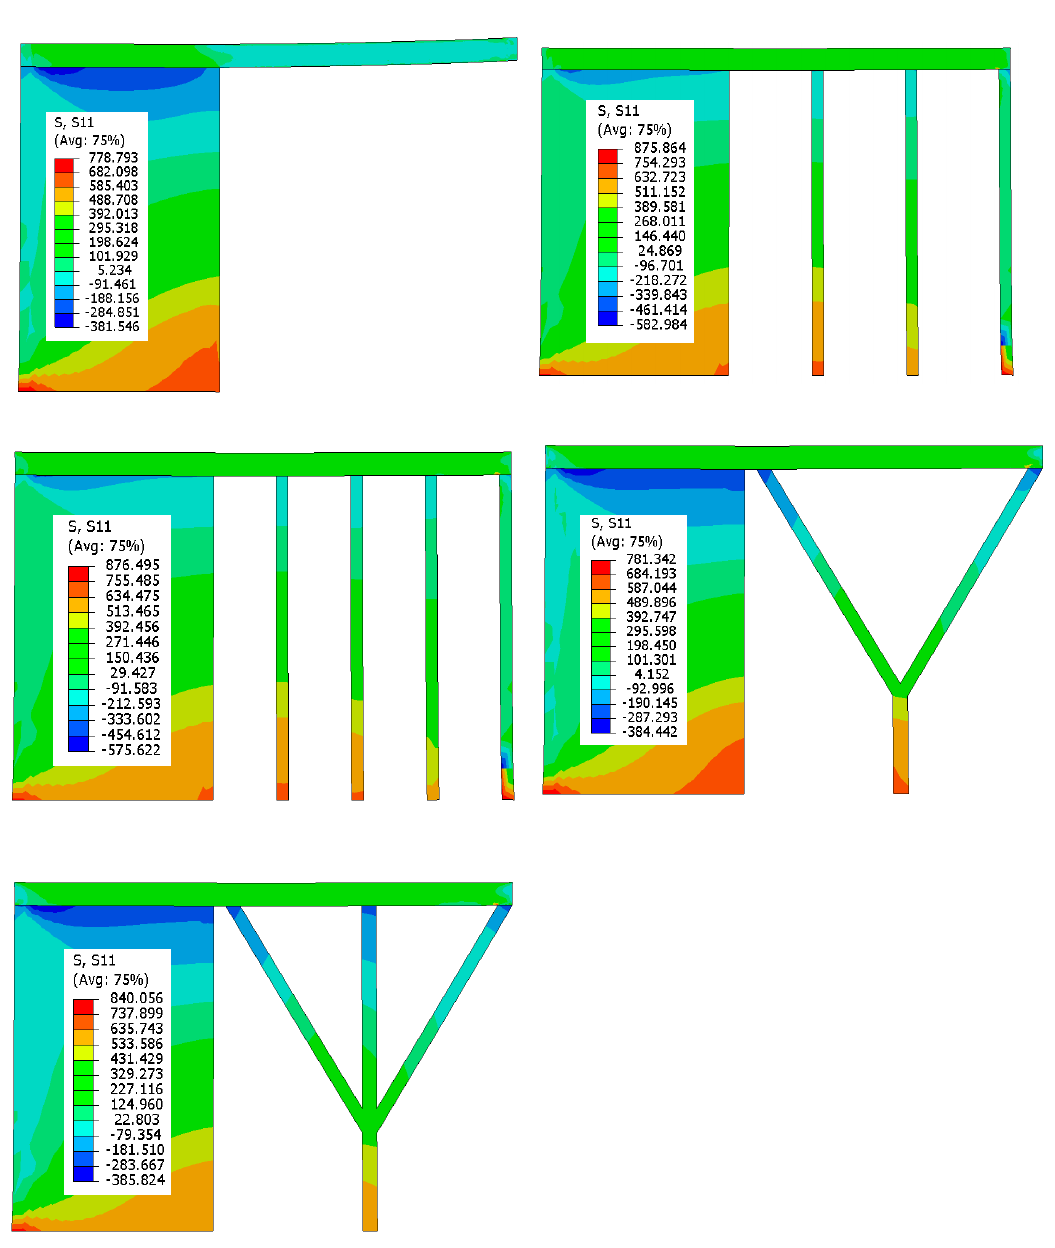
Figure 13. Residual stress distributions (MPa) when cooled down to room temperatures.